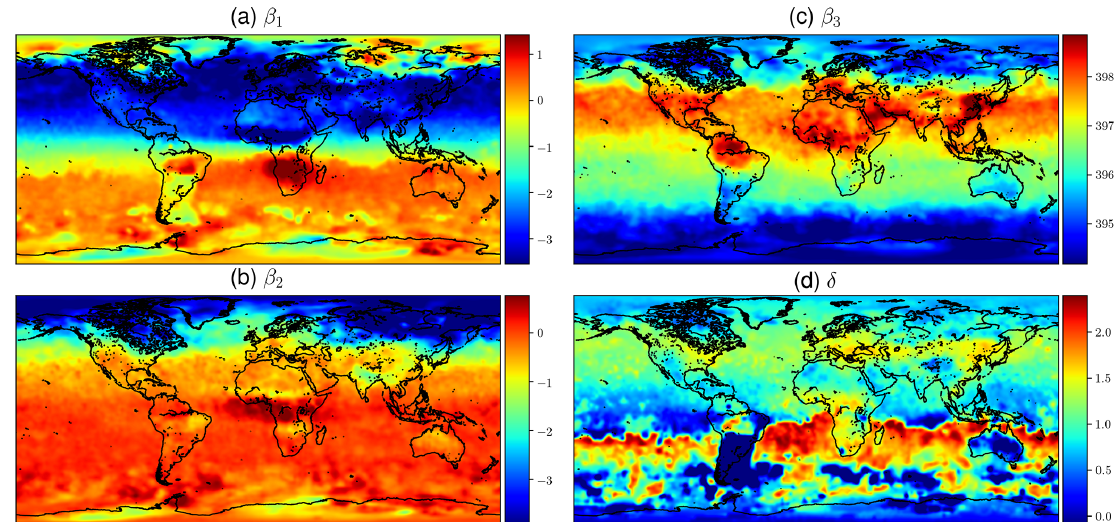
Figure 8. Mean values of mean function coefficients that were described as a Markov random field, calculated in a 2 ◦ × 2 ◦ grid between 85 ◦ N and 85 ◦ S. The β i coefficients multiply the f i functions in Eq. (11). Panel (d) shows how the phase parameter δ can vary more in the Southern Hemisphere where β 1 and β 2 are small. The mean function and fitted daily means for several locations with the corresponding mean function parameters are shown in Fig.